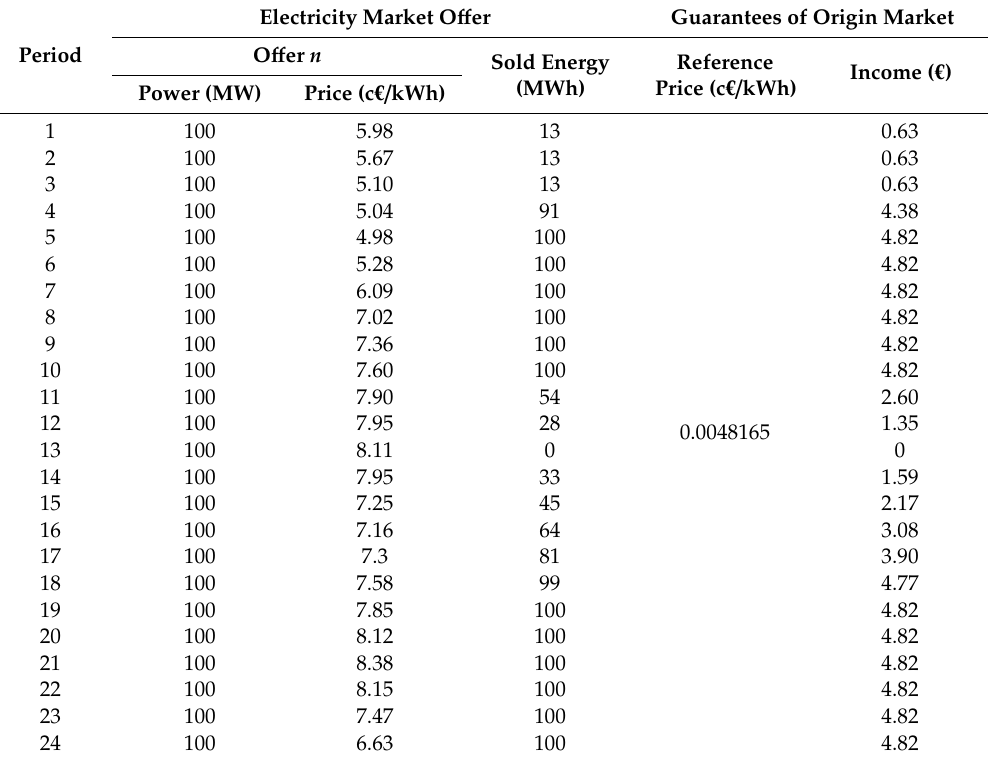
Figure 10. Energy sold on the market considering the results of Guarantees of Origin market.